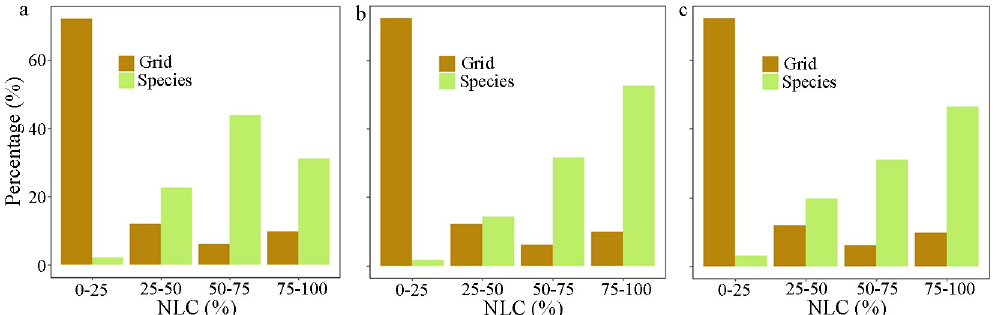
Fig 3. Percentage of grids with different NLC and species with different preferred NLC in the Netherlands. a, 1 122 native species. b, 230 threatened species. c, 503 rare species. The brown color means the distribution of grid cells with different NLC and the green color means the distribution of species with different preferred NLC.